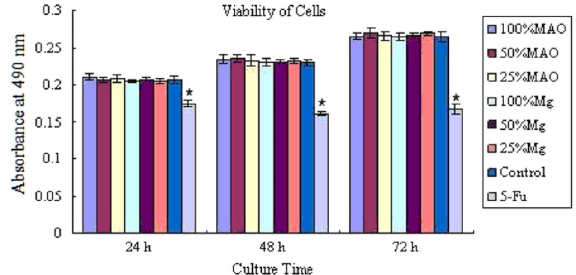
Figure 6. Saos-2 cells viability after 24, 48, and 72 h incubation in the extracts of MAO-coated and uncoated magnesium. *P , 0.05, 5-fluorouracil (5-Fu) compared to all other groups. MAO: micro-arc